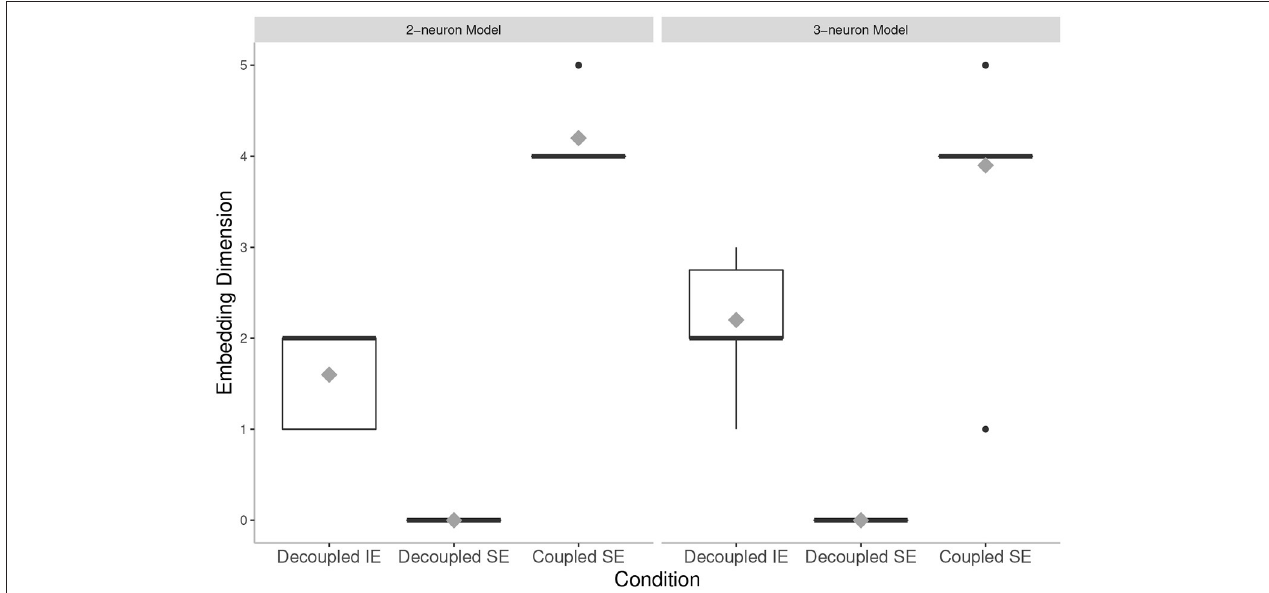
FIGURE 4 | Embedding dimension in all conditions tested: The mean values are presented by gray diamonds. The mean value of the Coupled Social Evolution (Coupled SE) condition in 2-neuron model is higher than the mean value of the Decoupled Individual Evolution (Decoupled IE) condition in 3-neuron model. Note that, for both models, in the Coupled SE condition, the mean values are higher than their intrinsic dimensional limitations (i.e., 2-dimensional and 3-dimensional systems, for the cases of 2-neuron and 3-neuron models, respectively). On the other hand, for both models, in the Decoupled Social Evolution (Decoupled SE) condition, the mean values are lower than their intrinsic dimensional